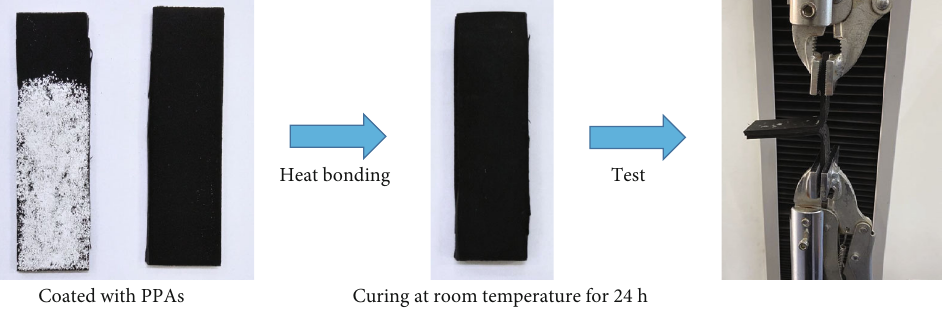
Figure 5: The T-peel strength